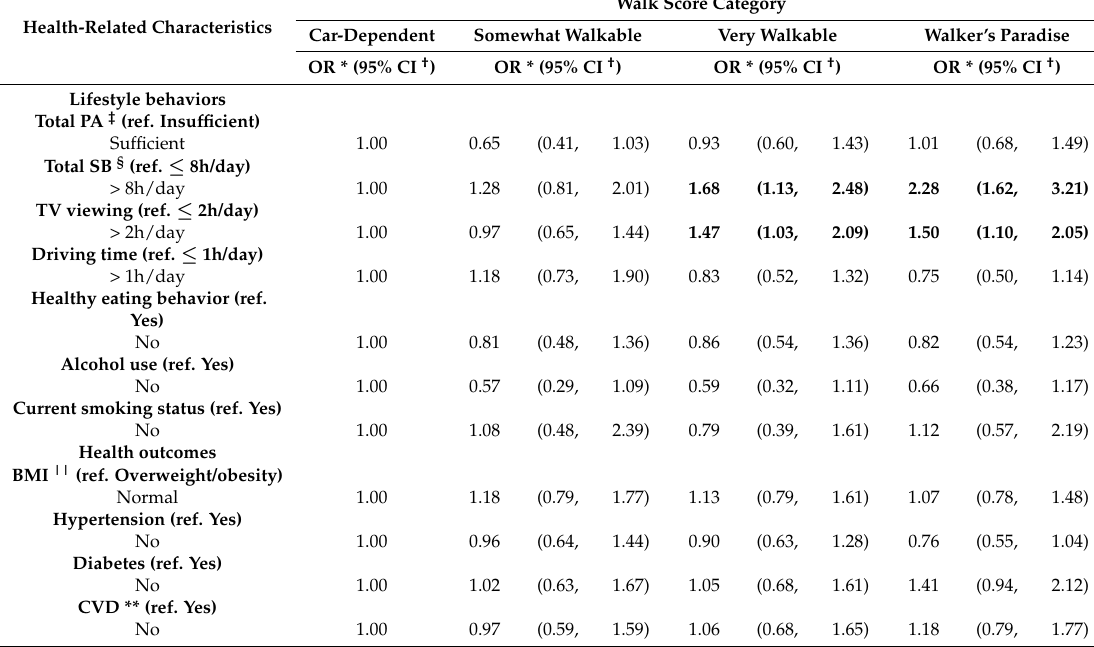
Table 3. Adjusted odds ratios (ORs) for the association of walk score category with lifestyle behaviors and health outcomes. Walk Score Category Car-Dependent Somewhat